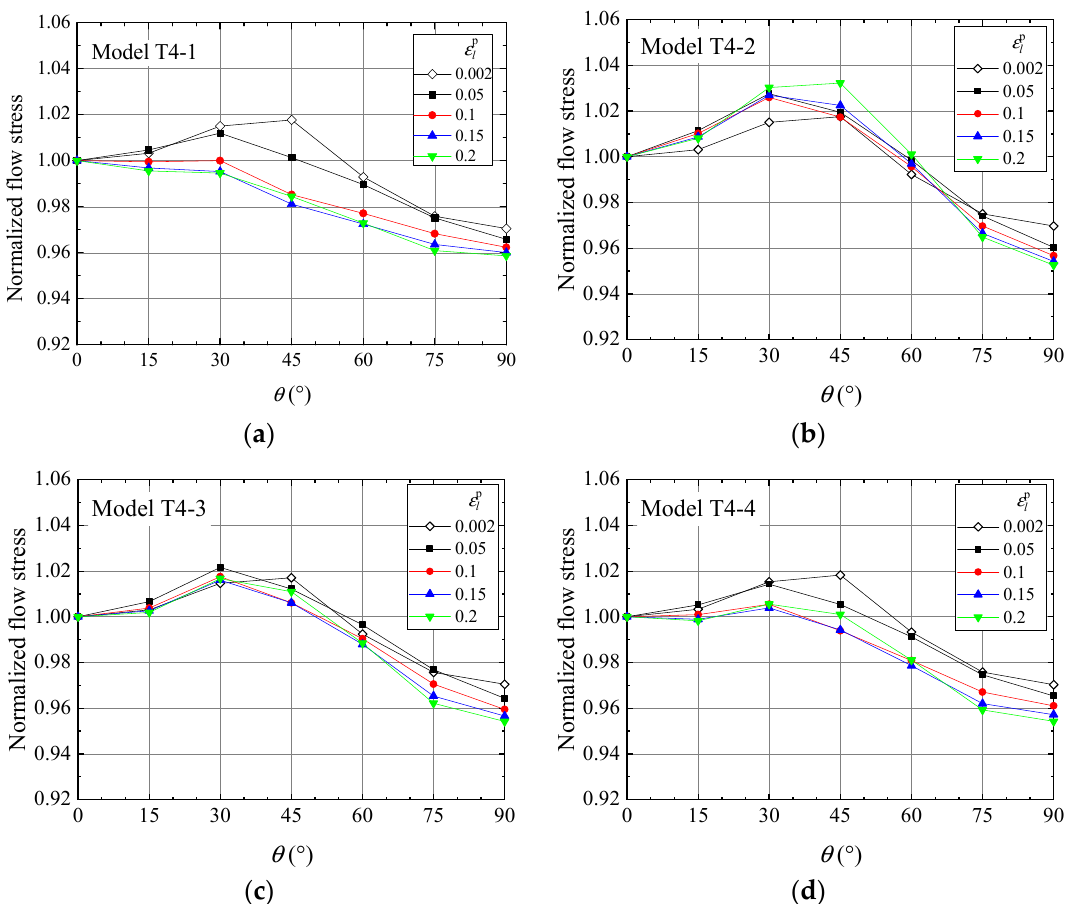
Figure 8. Crystal plasticity predictions of normalized flow stress with ( a ) model T4-1, ( b ) model T4-2, ( c ) model T4-3, and ( d ) model T4-4.